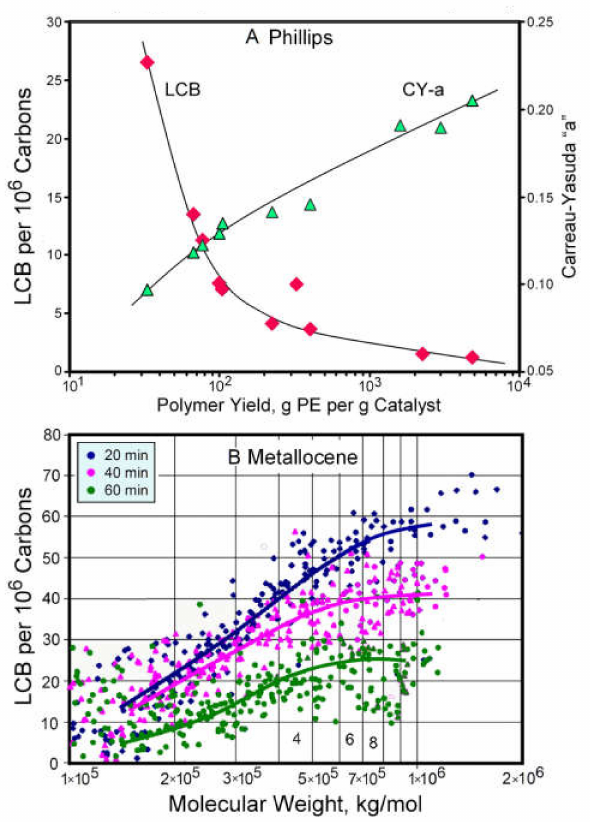
Figure 4. Reaction time was varied for Cr/silica-titania ( A above) and rac -Et(Ind) 2 ZrCl 2 on fluorided silica-alumina ( B